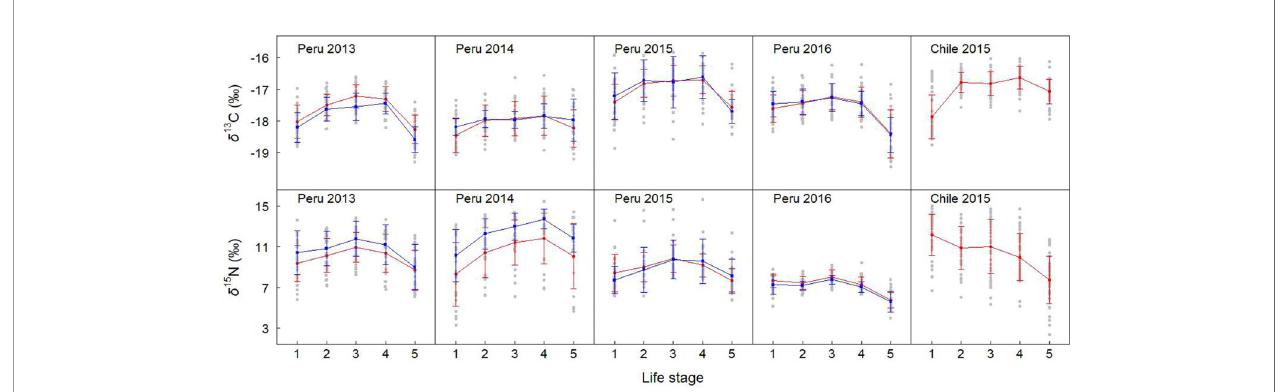
FIGURE 3 | Mean ± standard deviation isotopic values in lower beaks of females (red solid circle) and males (blue solid square) in each life stage. “ Peru 2013 ” represents the samples collected off Peru during 2013, and so on.